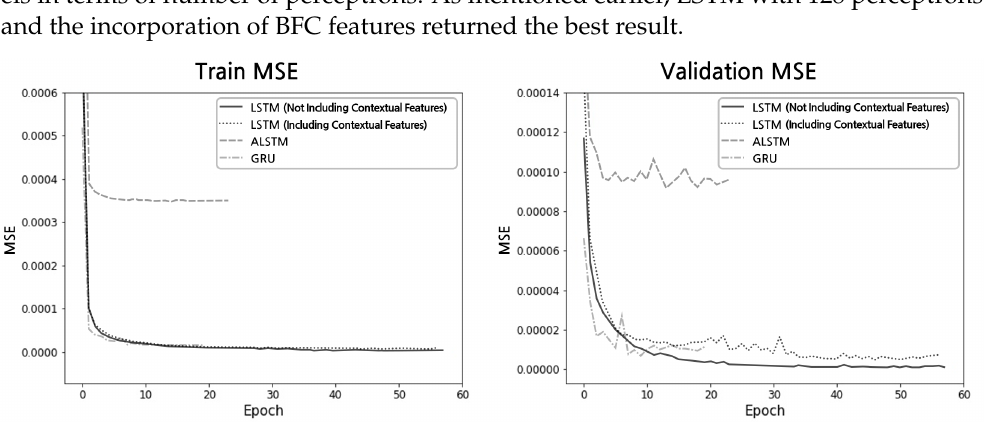
Figure 5. MSEs during training and